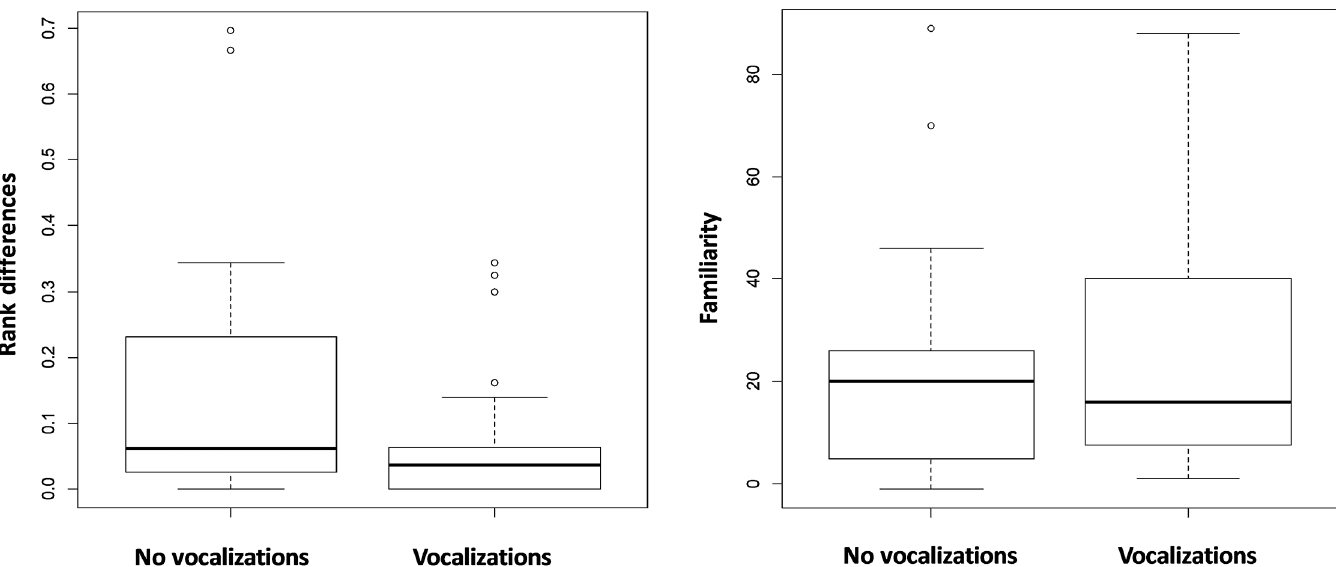
Fig 2. Box plots of differences in the index of familiarity (left) and rank differences (right) between opponents based on whether victims used vocalizations. Box edges represent the upper and lower quartiles, thick lines within the boxes represent medians,and open circles represent outliers (no vocalizations: n = 24; vocalizations: n = 48).